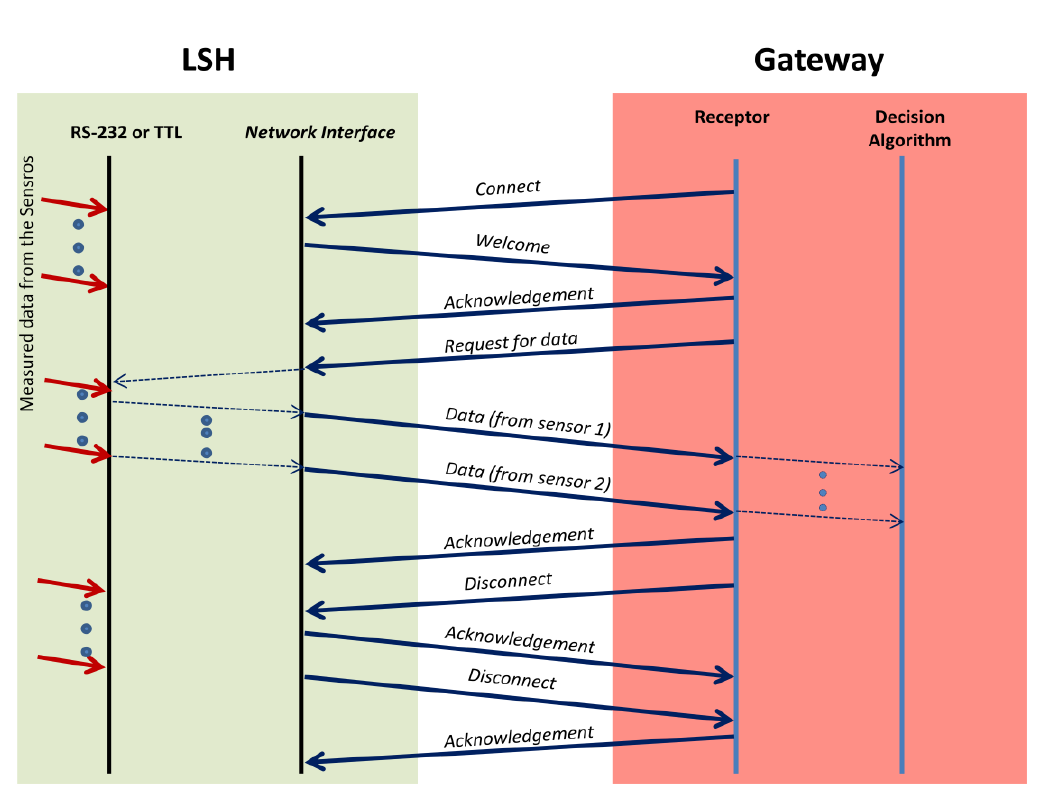
Figure 9. Communication protocol between LSH and the